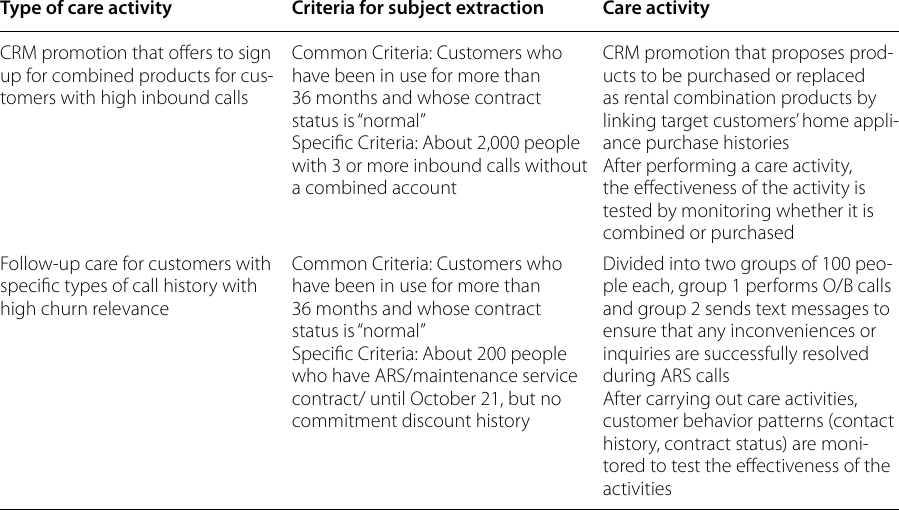
Table 9 Proposal to test operation of care activities for customer churn prevention Type of care activity Criteria for subject